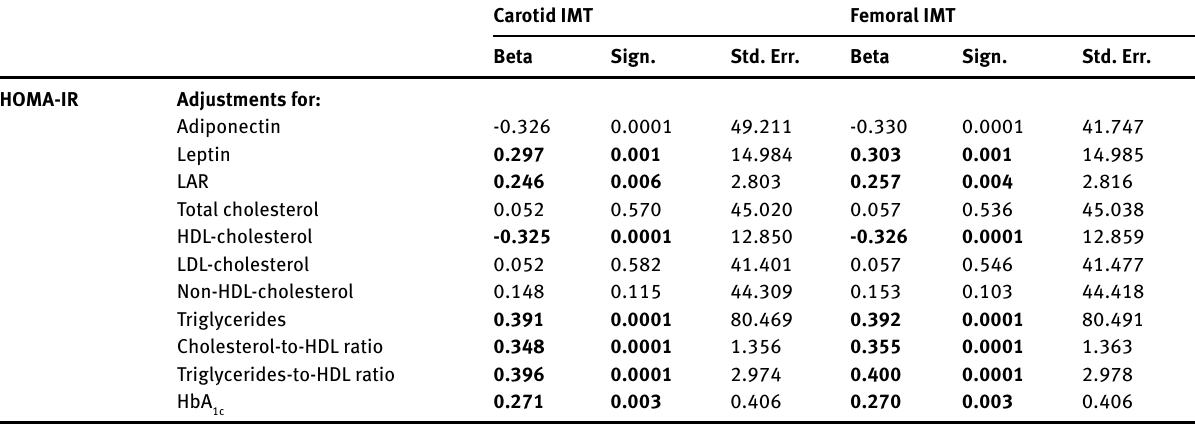
Table 6: Multiple linear regression models: the relationships between IMT values and HOMA-IR adjusted for adipokines, lipid profile and HbA1c